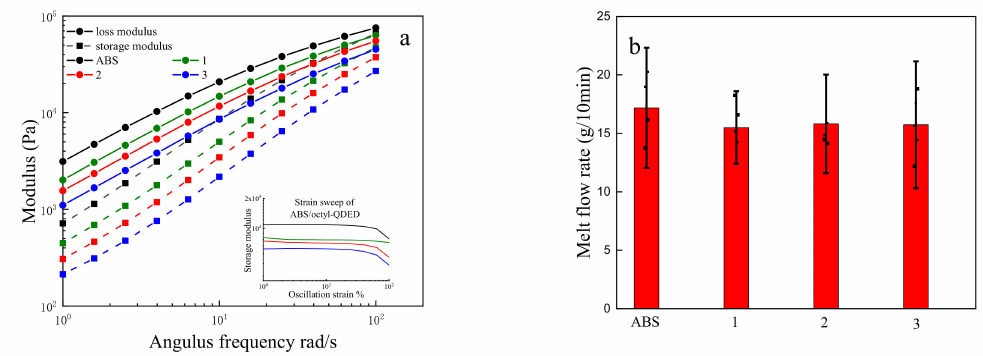
Figure 5. ( a ) Dynamic frequency sweep and ( b ) melt flow rate (MFR) of ABS /